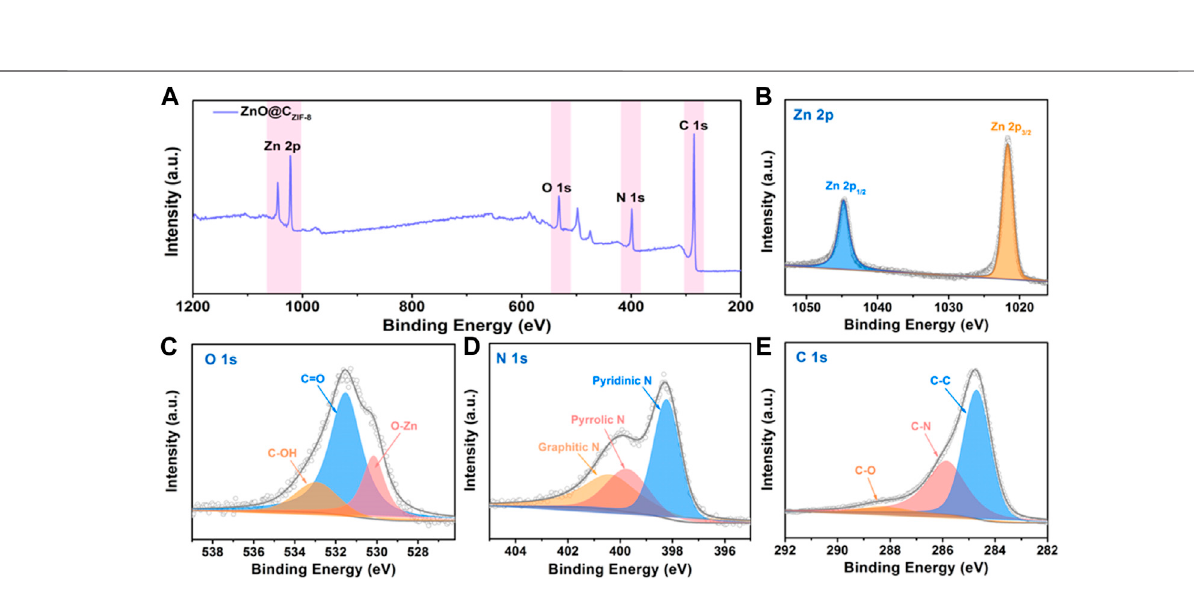
Frontiers in Chemistry |